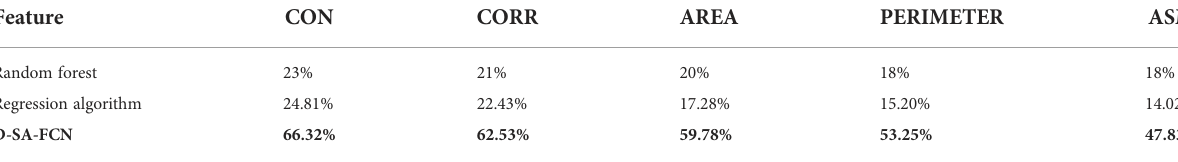
TABLE 6 Features and mechanical properties response.